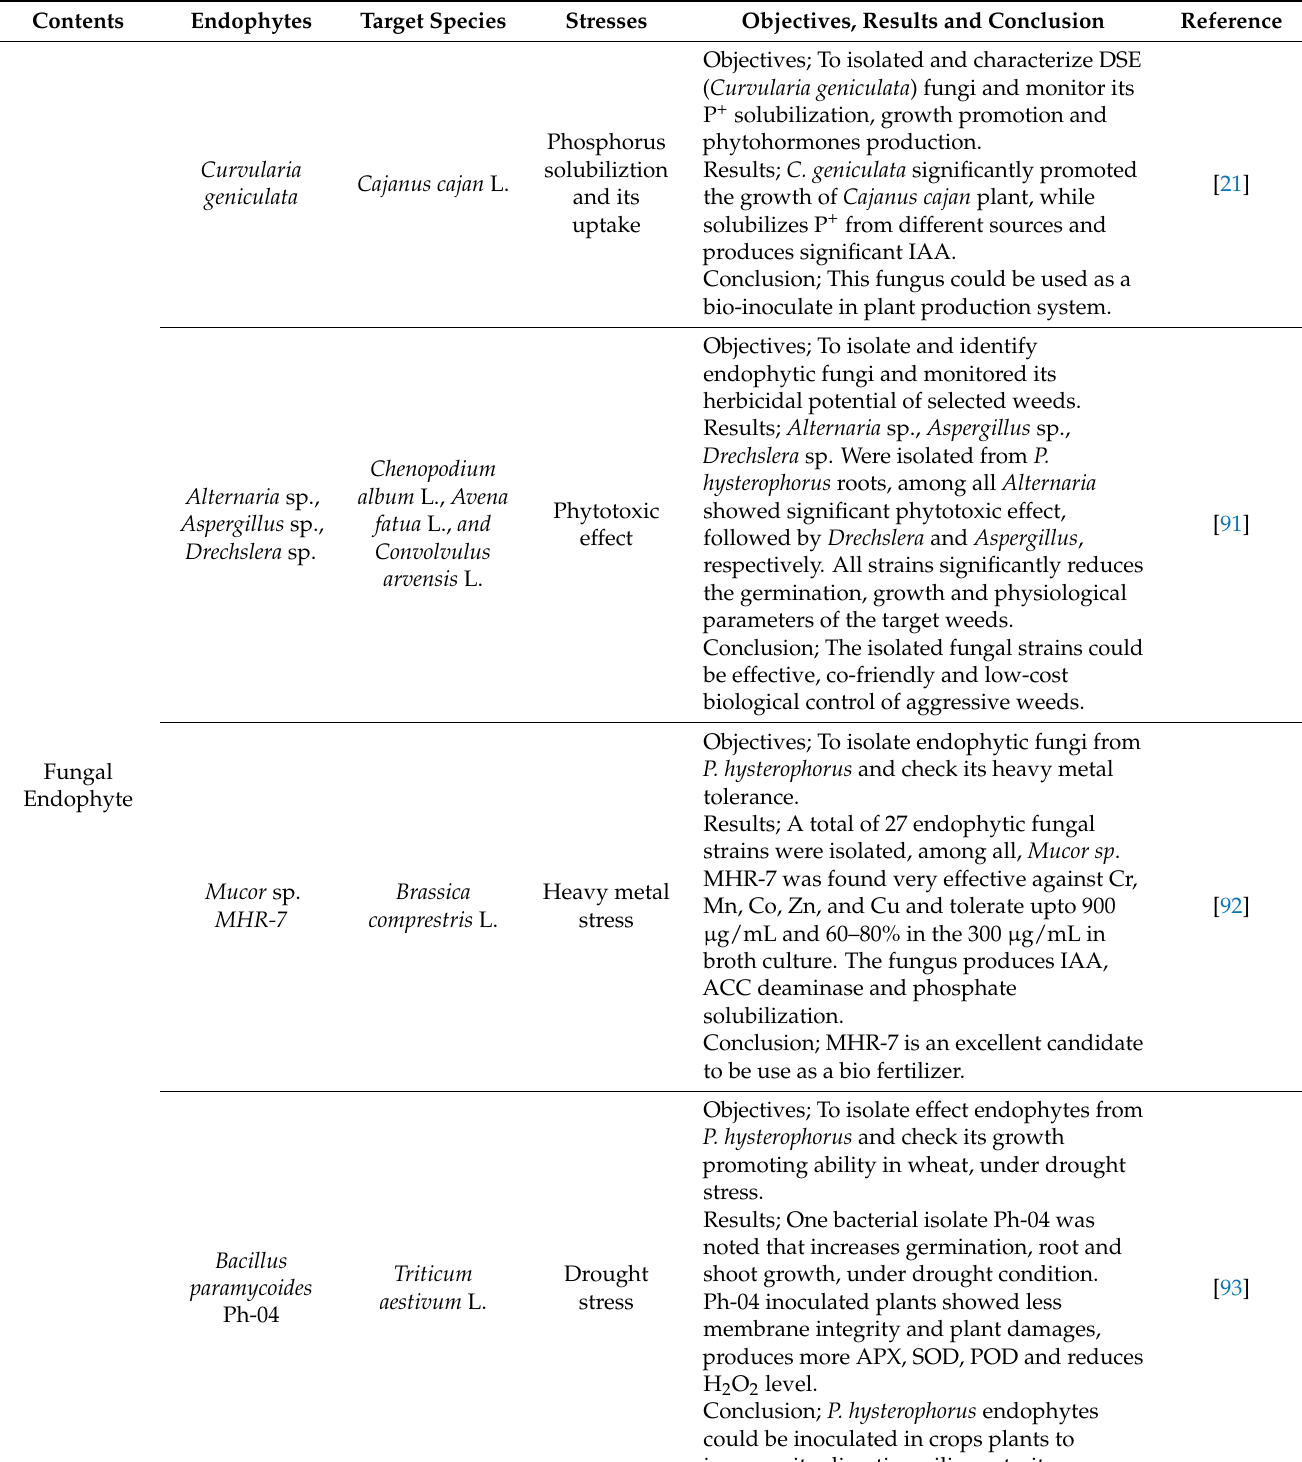
Table 1. Summary of documented researches on the endophytes from Parthenium hysterophorus L. and its role in different biotic and abiotic